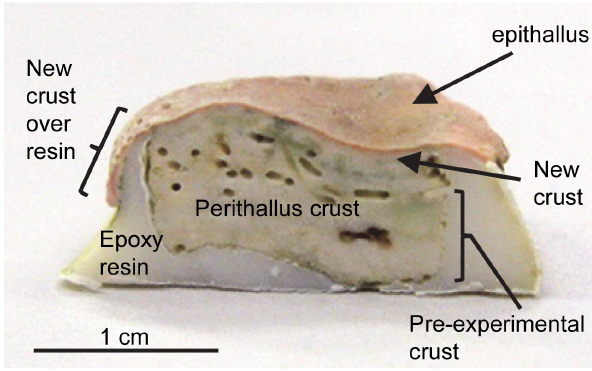
Figure 1. Example of P. onkodes after 3months. New crust over- growing resin used for